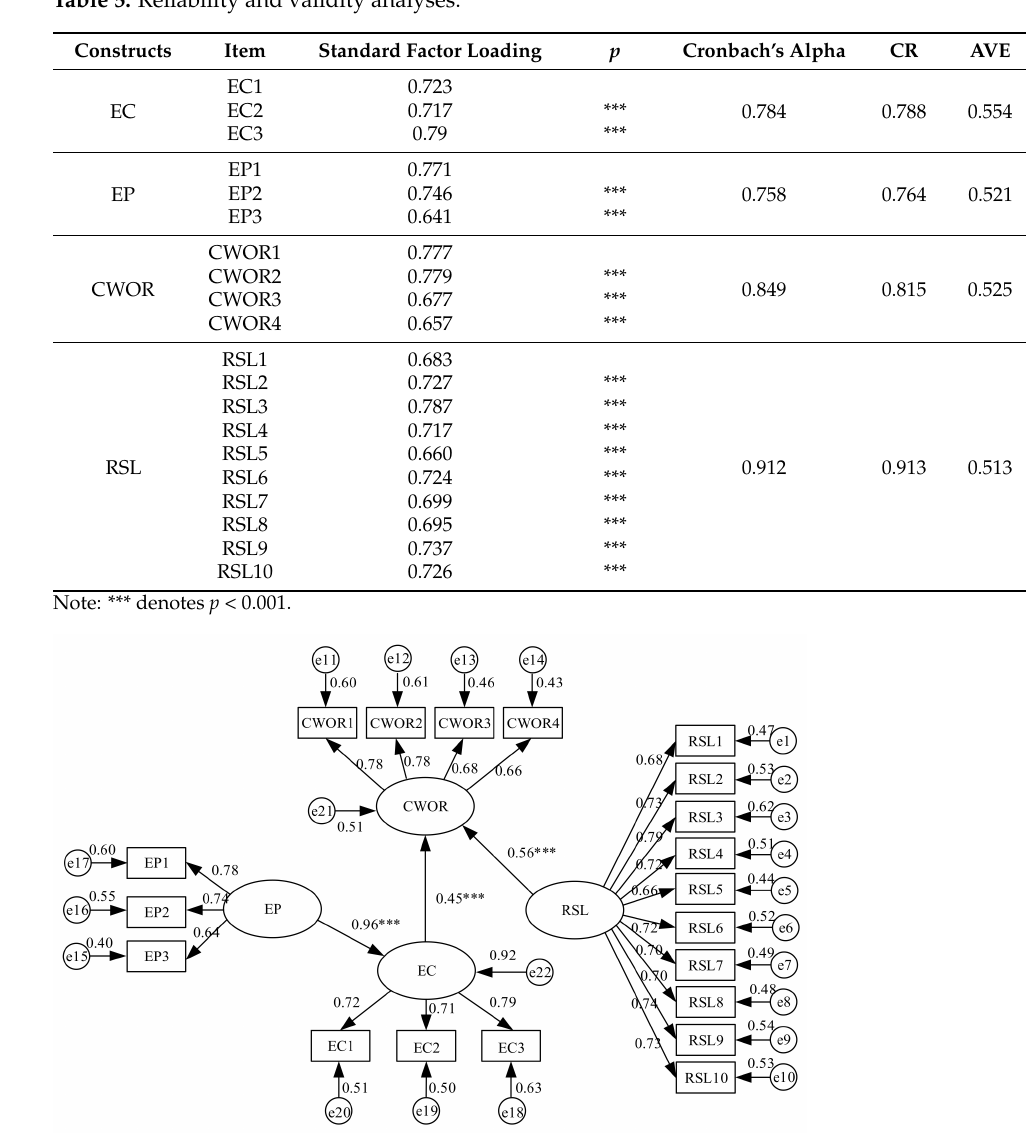
Table 5. Reliability and validity analyses.